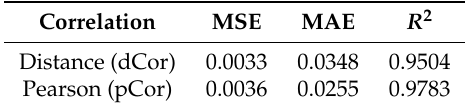
Table 2. Correlation regression scores obtained for the test